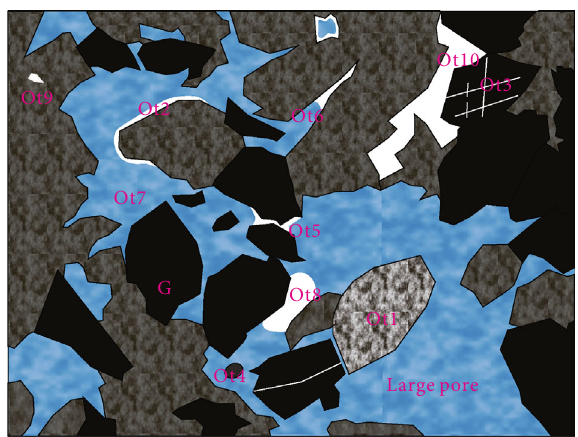
Figure 16: Microscopic remnant oil distribution patterns. G: grain; Ot: oil type; Ot1: adsorbed-particle-shaped; Ot2: oil- fi lm-shaped; Ot3: slit-shaped; Ot4: pore-center-precipitation-shaped; Ot5: throat- shaped; Ot6: corner-shaped; Ot7: foggy-shaped; Ot8: intergranular-adsorbed-shaped; Ot9: intragranular-shaped; Ot10: cluster